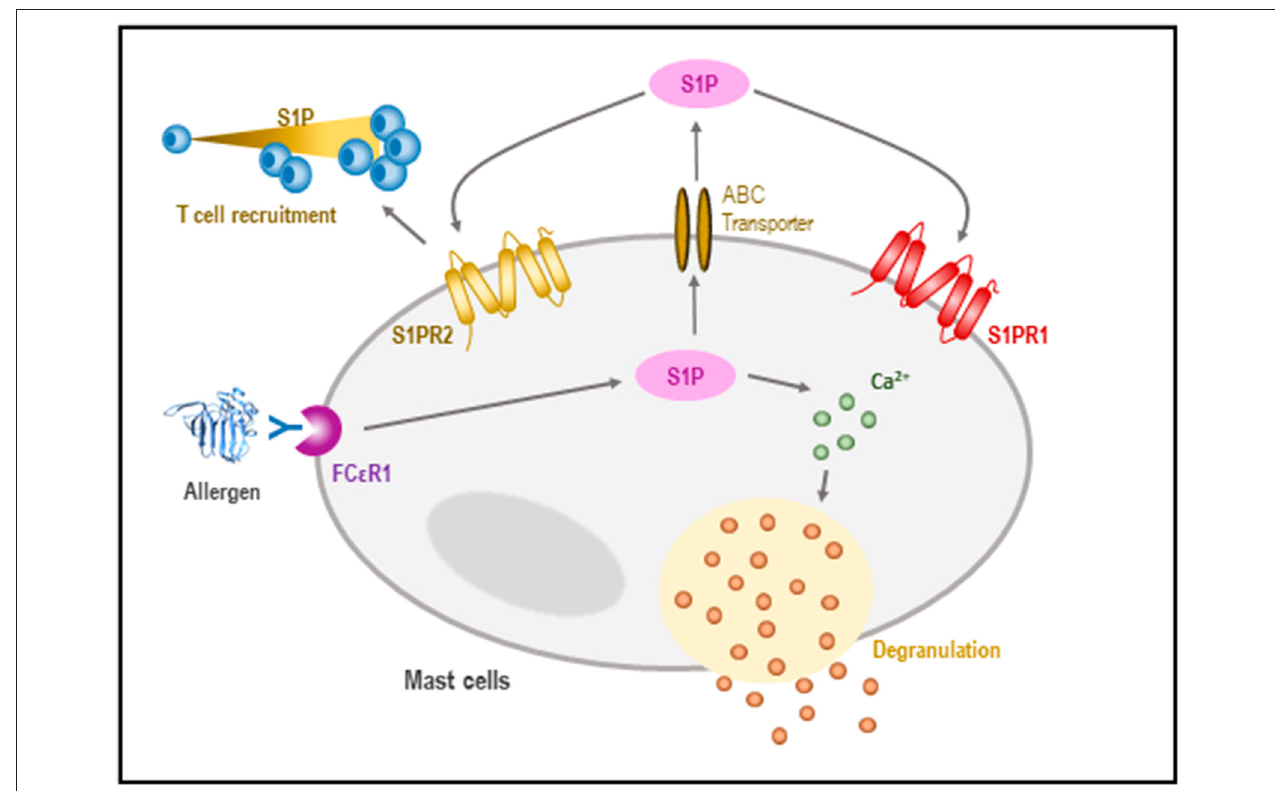
FIGURE 4 | Role of S1P in the regulation of mast cells (MCs). In response to an antigen, the activation of SphK takes place, leading to the formation of S1P. S1P may influence calcium homeostasis, allowing MC degranulation. Likewise, S1P can be released outside the cell, where it is recognized by sphingosine receptors which promote both chemotaxis and T-cell